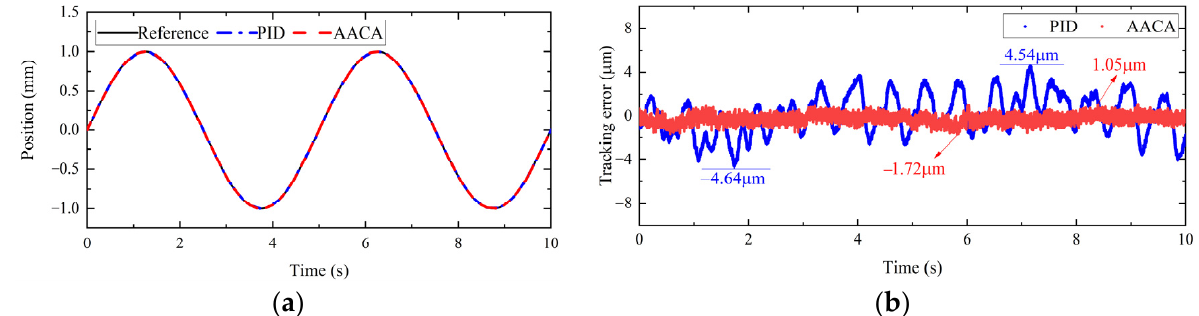
tion by CHLS. ( a ) Tracking responses. ( b ) Tracking errors.